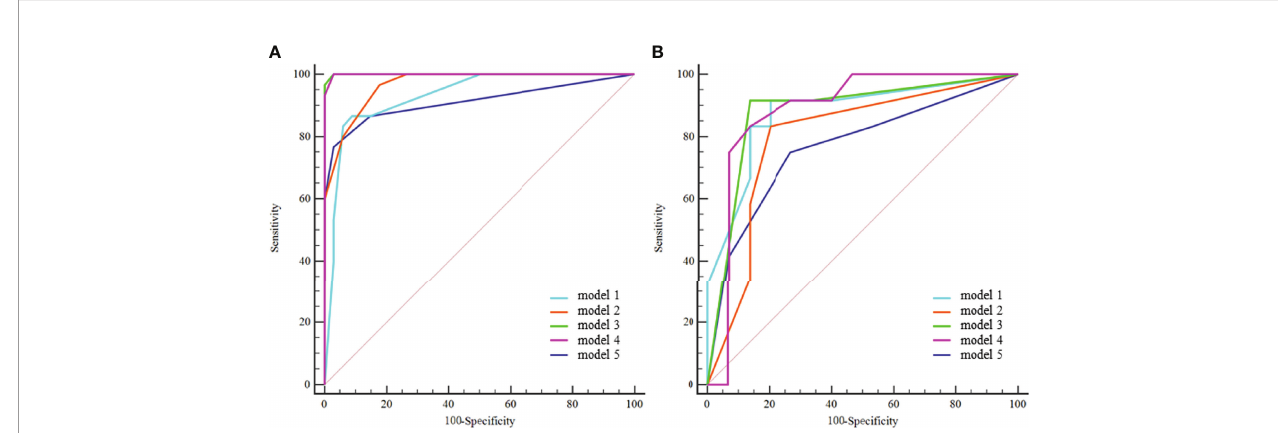
FIGURE 3 | ROC curves of the fi ve models in the training cohort (A) and validation cohort (B) . model 1 = radiomics model_IVC; model 2= radiomics model_TT; model 3 = combined model_IVC; model 4 = combined model_TT; model 5 = radiological model.